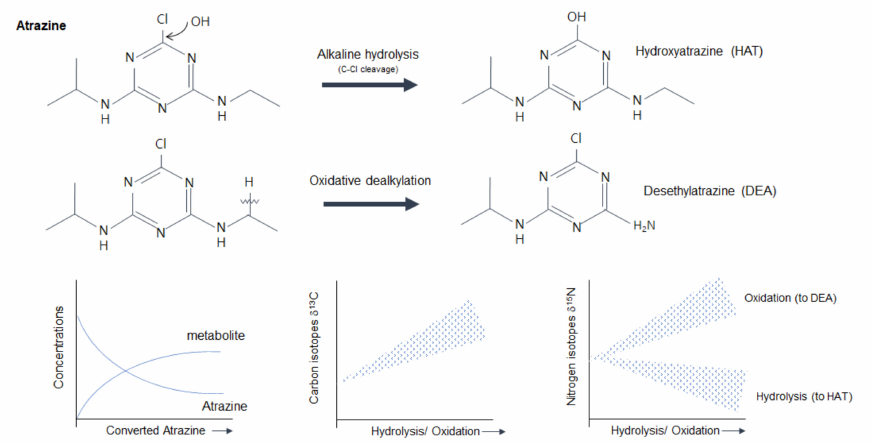
Figure 2. Atrazine concentrations and its degradation products (hydroxtatrazine and desethyla- trazine), and corresponding δ 13 C (bottom left) and δ 15 N values (bottom right) during hydrolysis and dealkylation. The figure on the far left shows the concentrations of atrazine and its metabolites, and the Y -axis of the two figures on the right shows the carbon and nitrogen stable isotope ratios of atrazine observed differently as atrazine is metabolized ( X -axis),